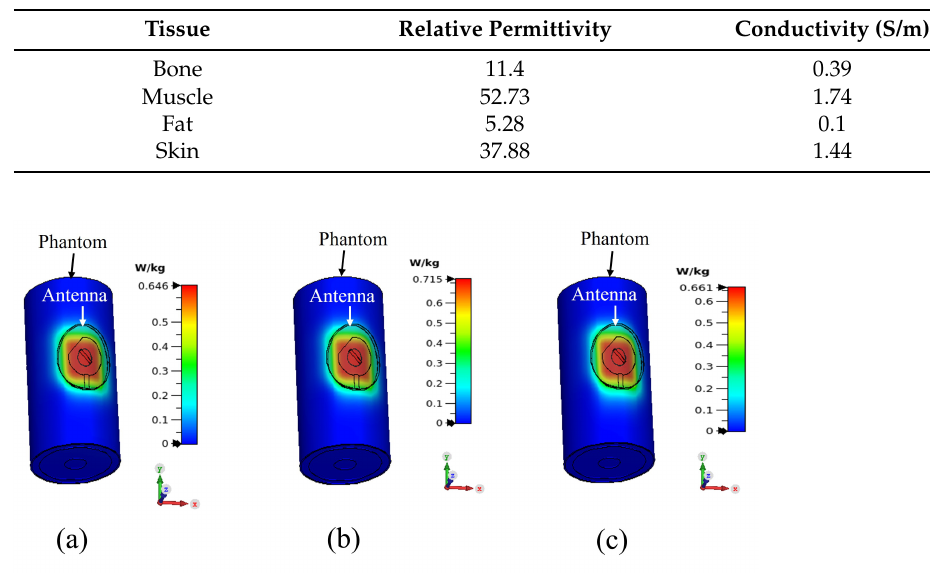
Figure 20. SAR distributions in the multilayer phantom at: ( a ) 2.4 GHz, ( b ) 2.45 GHz and ( c ) 2.6